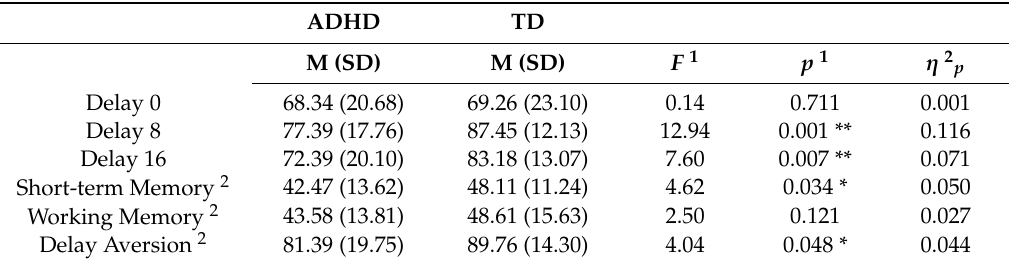
Figure 2. Percentage correct trials on the CDL with delays of 0, 8, and 16 s for children with ADHD (Attention Deficit Hyperactivity Disorder) and TD (Typically Developing) children. As indicated in the graph, children with ADHD performed fewer correct trials compared to TD children at delays of 8 and 16 s. ** p < 0.01. Table 2. Untransformed Mean Percentages, Standard Deviations, and Multivariate ANOVA Results for the Conditional Discrimination Learning, Short-Term Memory, Working Memory, and Delay Aversion tasks: ADHD and Control